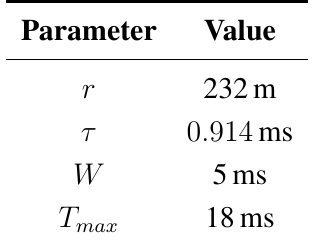
Table 2. Simulation